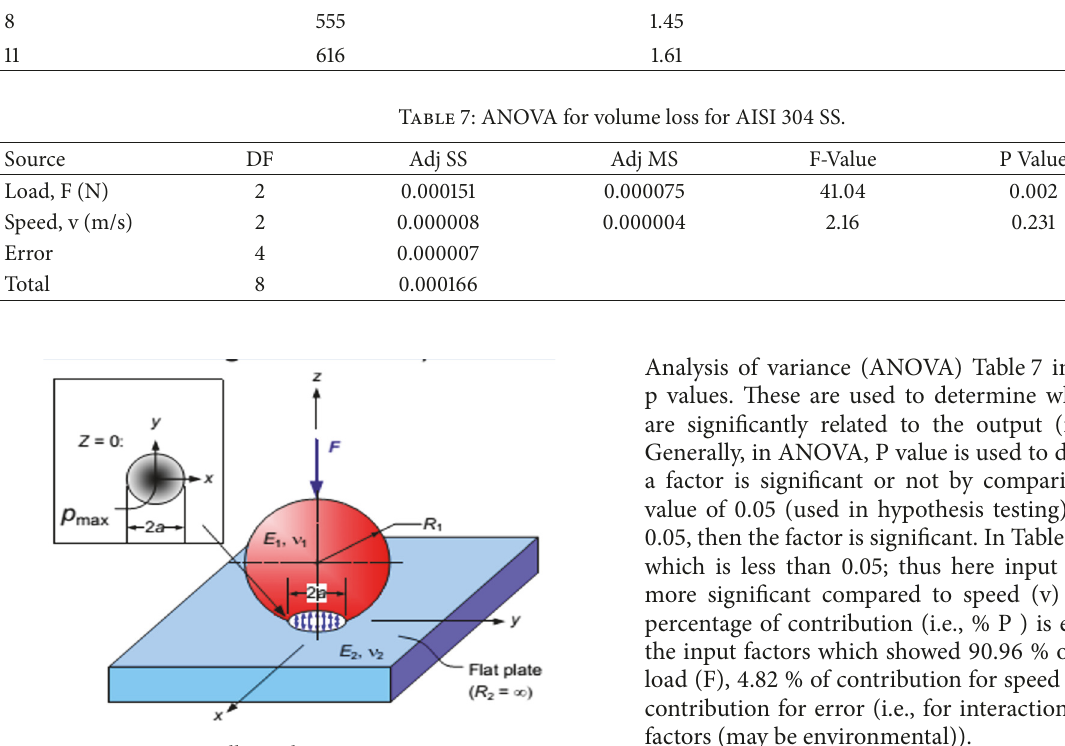
Figure 6: Ball-on-plate contact